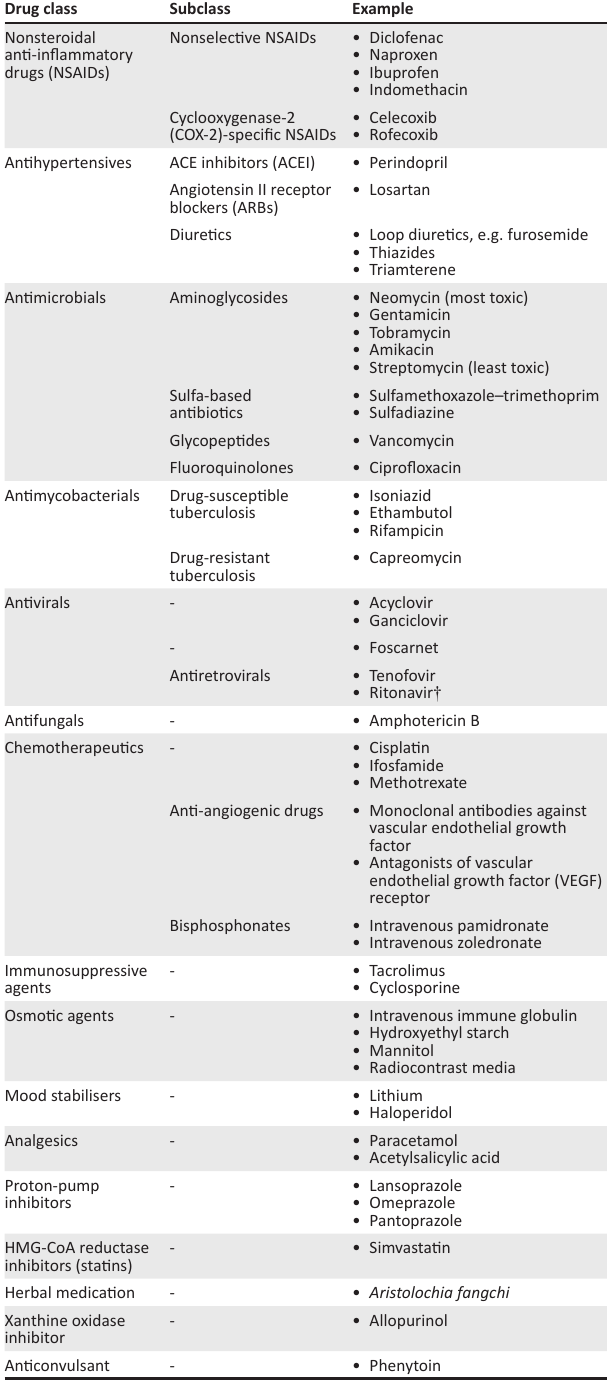
TABLE 2: Medication with nephrotoxic potential. TABLE 1: Common causes of acute kidney injury and chronic kidney disease in